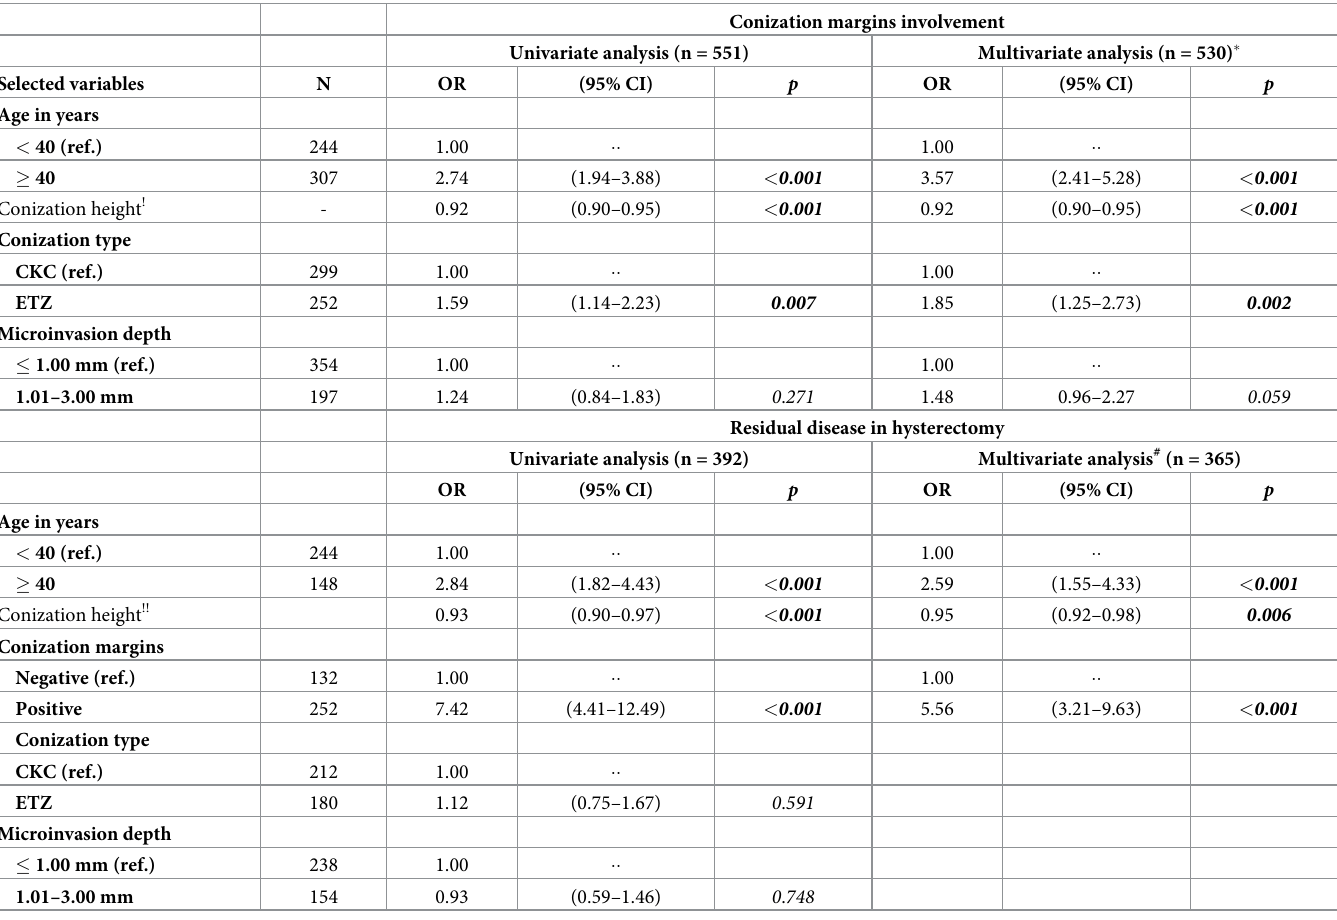
Table 2. Factors related to conization margins involvement and residual disease in hysterectomy specimens for microinvasive squamous cell carcinoma of the cervix stage IA1, according to univariate and multivariate logistic regression